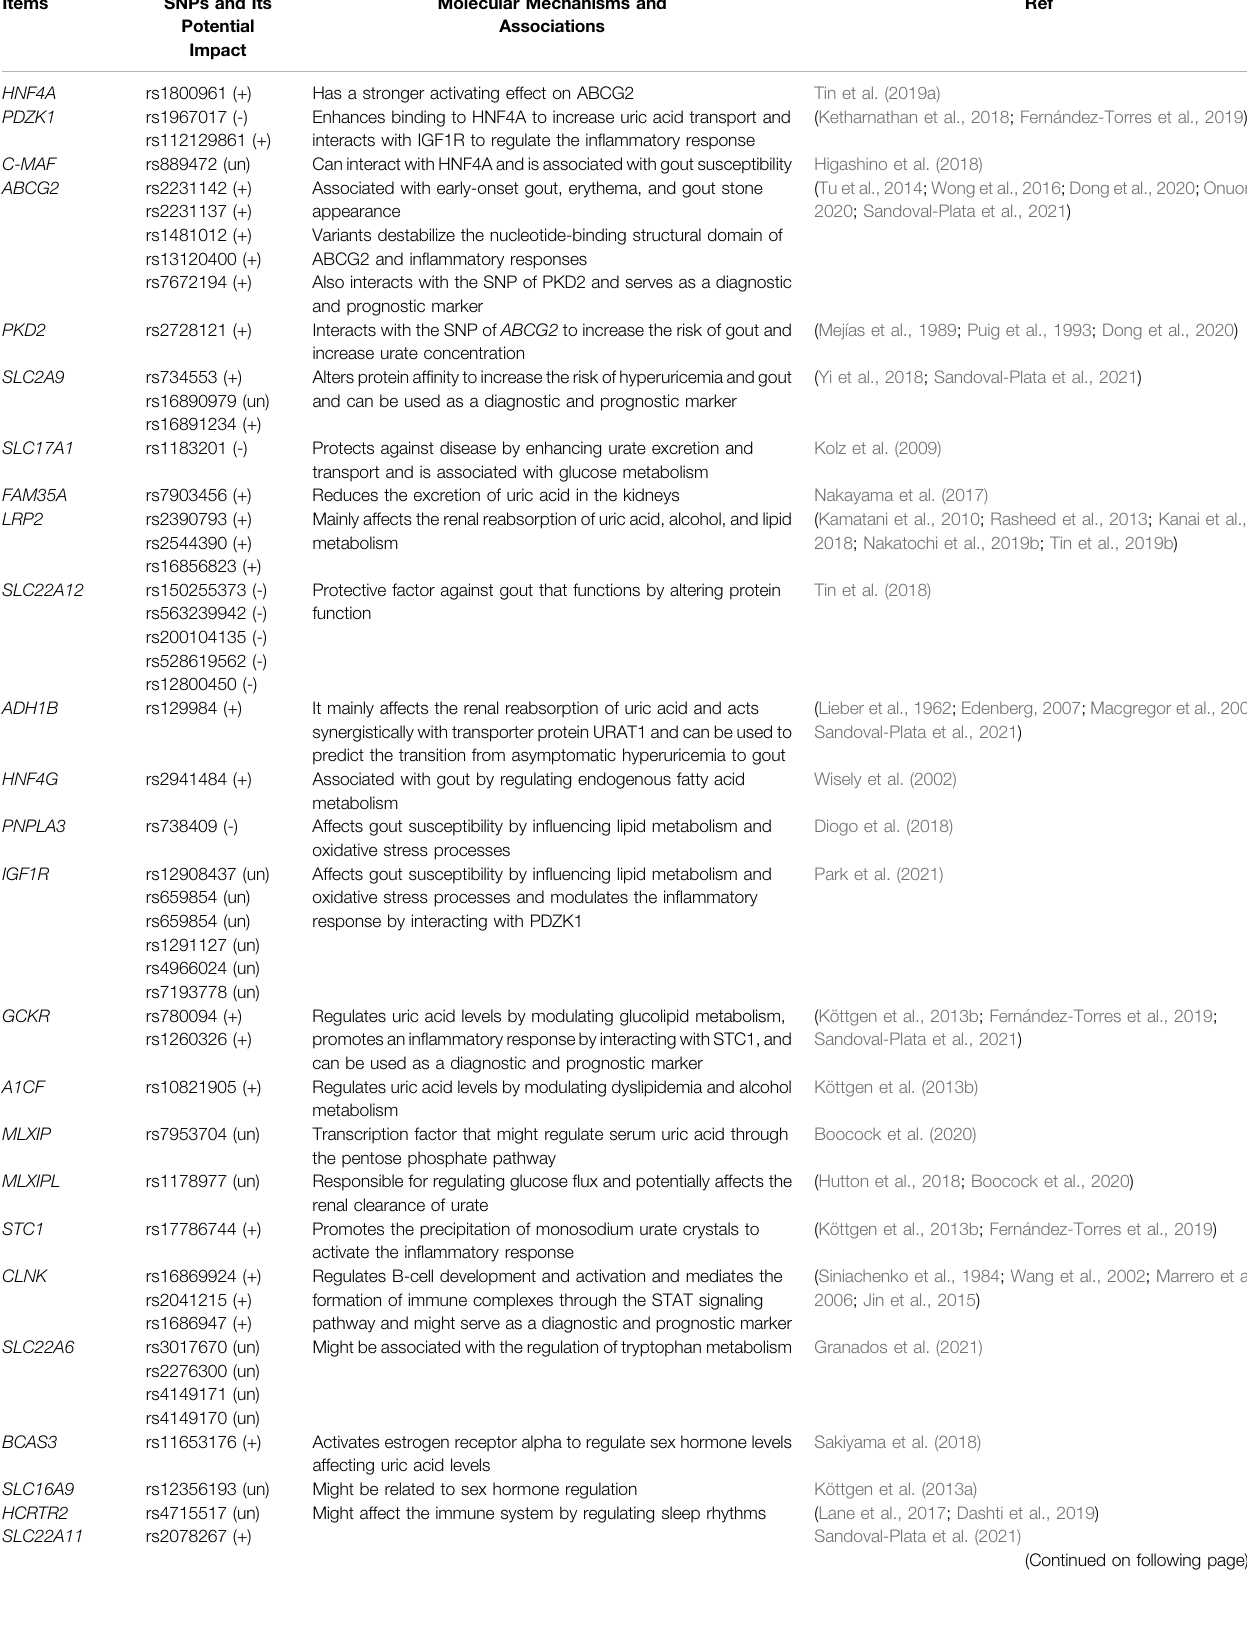
TABLE 1 | Gene variants associated with hyperuricemia and